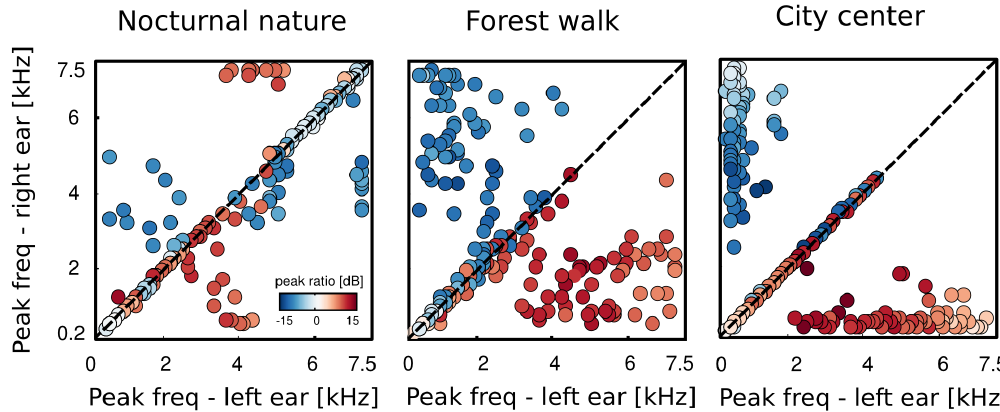
Figure 10. Binaural composition of independent components. Each circle corresponds to a single IC. Horizontal and vertical coordinates are spectral maxima of the left and the right ear parts respectively. Colors encode the peak power ratio. Each pannel depicts one of the recorded scenes.